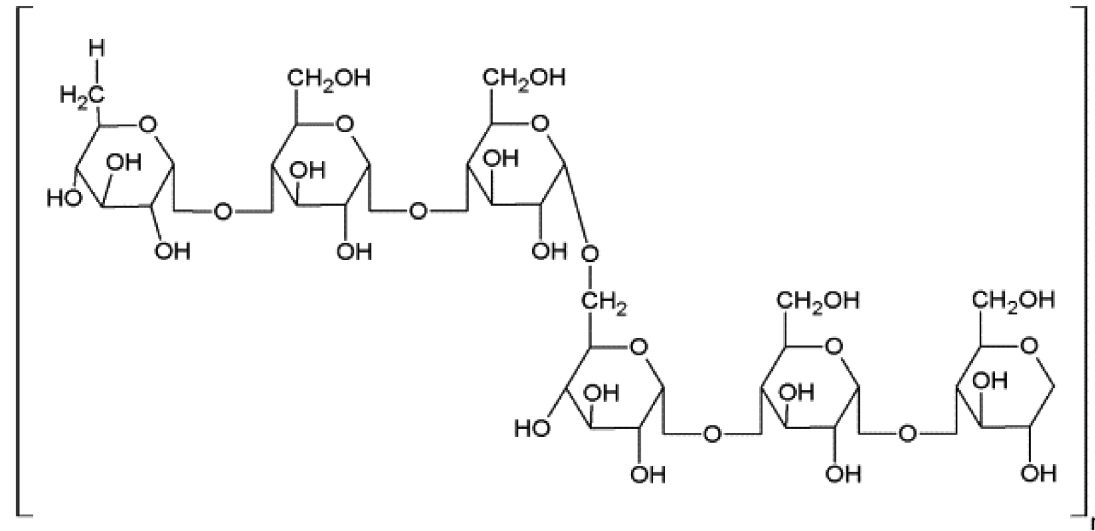
FIGURE 1 - Pullulan chemical